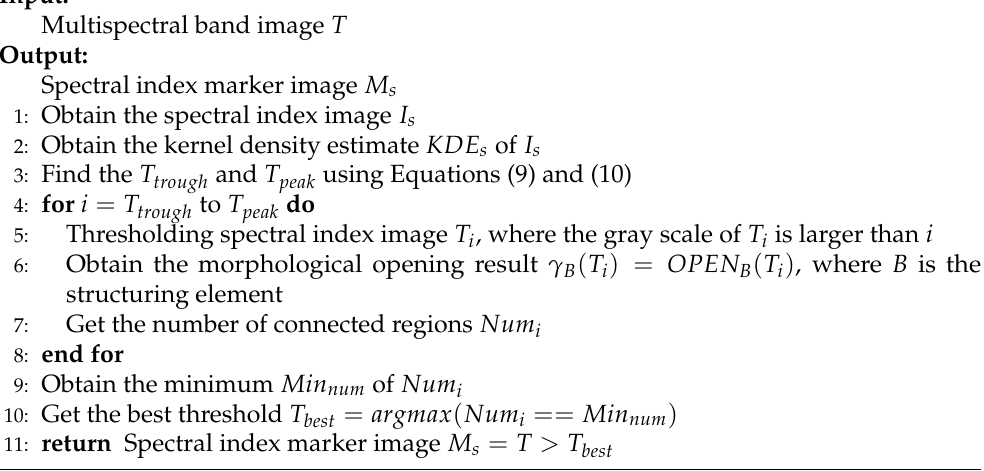
Algorithm 2 Obtaining the optimal thresholds of spectral indices for generating marker